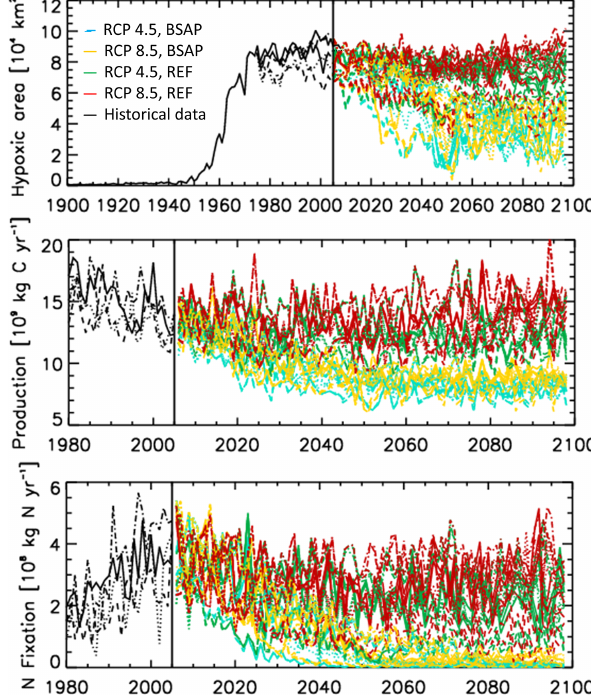
Figure 23. From top to bottom: hypoxic area (in km 2 ), volume- averaged primary production (in kgCyr − 1 ) and volume-averaged nitrogen fixation (in kgNyr − 1 ) for the entire Baltic Sea, includ- ing the Kattegat (see Fig. 1) in the historical (until 2005, black lines) and scenario (after 2005, coloured lines) simulations driven by four regionalised ESMs (illustrated by different line types) un- der RCP4.5, BSAP (blue), RCP4.5, REF (green), RCP8.5, BSAP (orange) and RCP8.5, REF (red) scenarios. A spin-up simulation since 1850 was performed, as illustrated by the evolution of hy- poxia. (Source: Meier et al., 2021; their Fig. 4 distributed under the terms of the Creative Commons CC-BY 4.0 License,